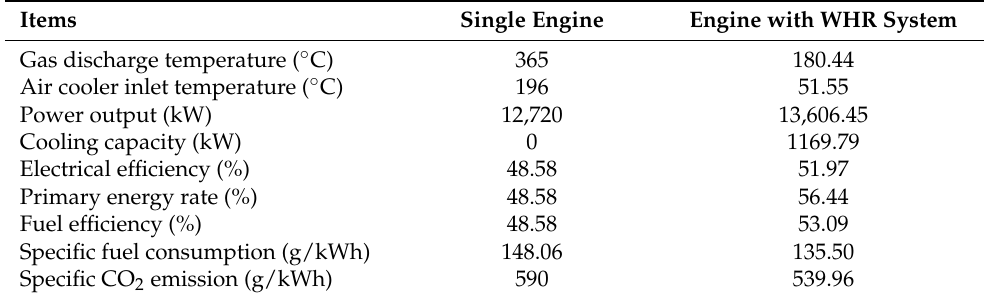
Table 6. System performance comparison of the engine and the proposed combined